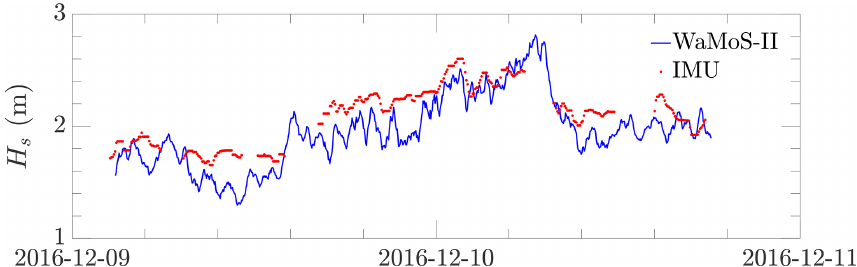
Figure 4. Time series of significant wave height H s : benchmark observations derived from ship motion data (red dots) and calibrated records from WaMoS-II (blue solid line).